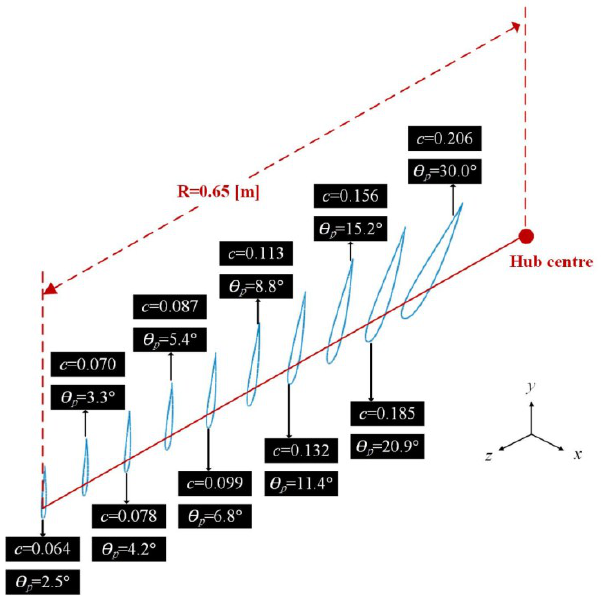
Figure 11. Layout of the chord length and pitch angle for the designed turbine